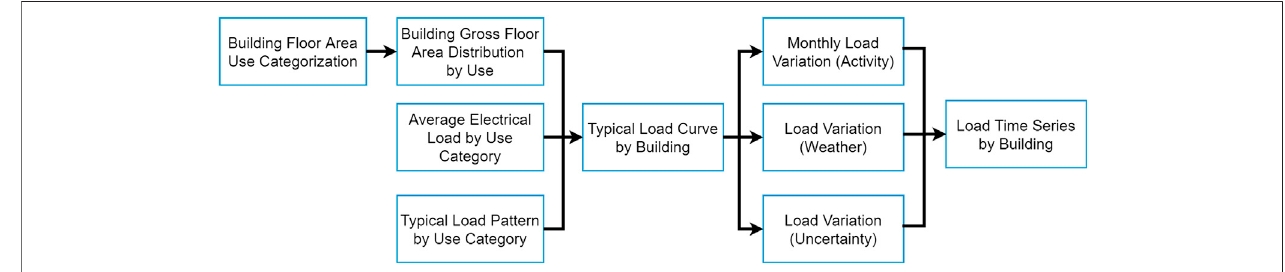
FIGURE 2 | PDD load estimation work fl